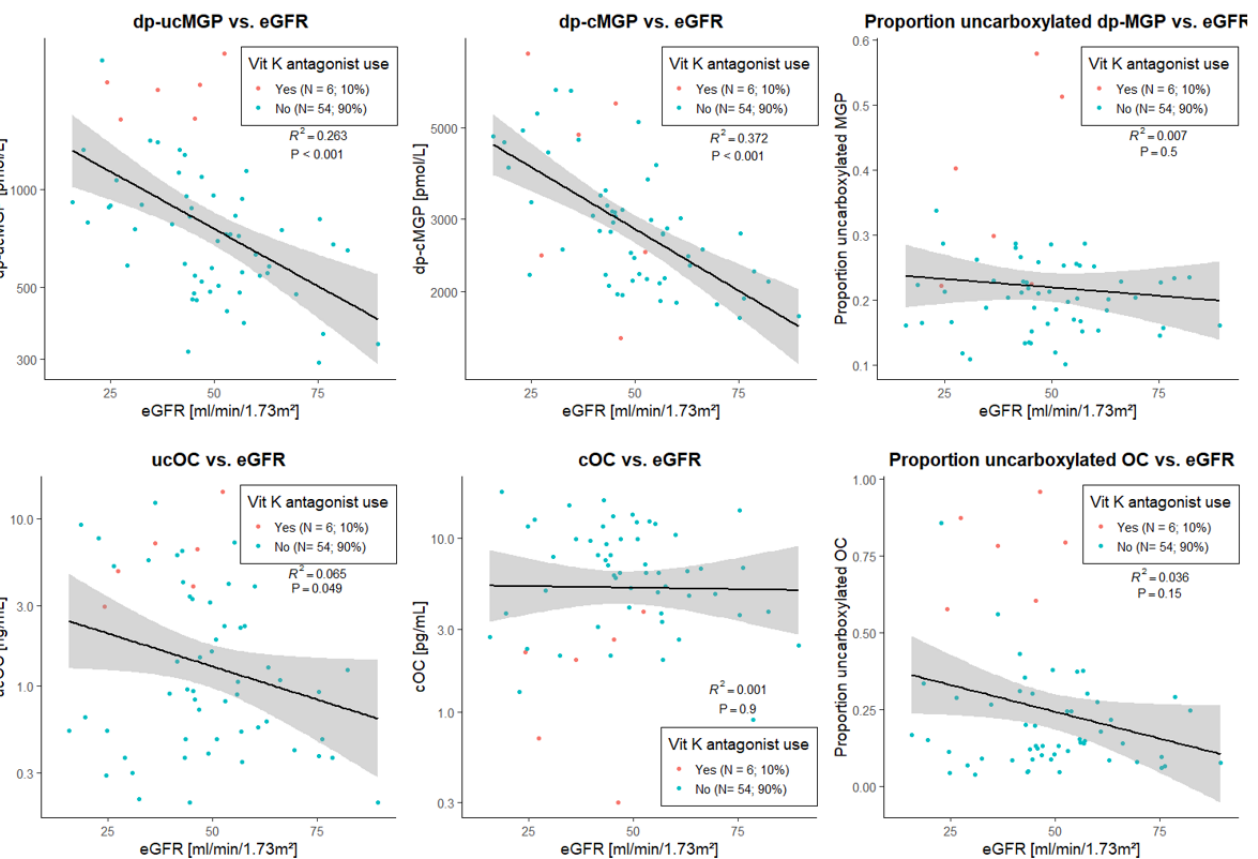
Figure 4. Visual presentation of the univariable linear association of uncarboxylated, carboxylated and proportion uncar- boxylated matrix Gla protein and osteocalcin with eGFR, in a subgroup of 60 kidney transplant recipients from cohort 1. In brief, both dp-ucMGP and dp-cMGP were strongly negatively associated with eGFR, whereas the negative association of ucOC with eGFR was less pronounced. No statistically significant associations of cOC, proportion of uncarboxylated dp-MGP and proportion of uncarboxylated OC were found with eGFR. Abbreviations: dp-ucMGP, dephosphorylated uncarboxylated matrix Gla protein; dp-cMGP, dephosphorylated carboxylated matrix Gla protein; eGFR, creatinine-based estimated glomerular filtration rate; ucOC, uncarboxylated osteocalcin; cOC, carboxylated osteocalcin.